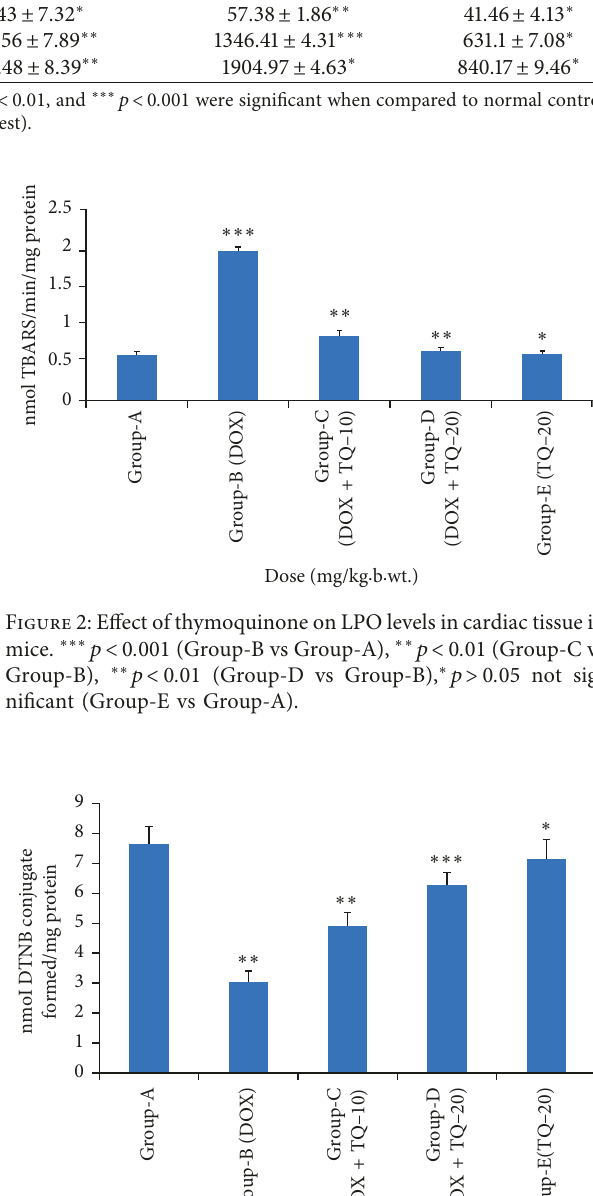
Table 1: The effect of thymoquinone on serum marker enzymes in doxorubicin-mediated cardiotoxicity in the mice. Enzymes Group A (control) Group B (DOX) Group C (DOX +TQ10) Group D (DOX +TQ-20) Group E (TQ-20) AST (IU/ml) 45.34